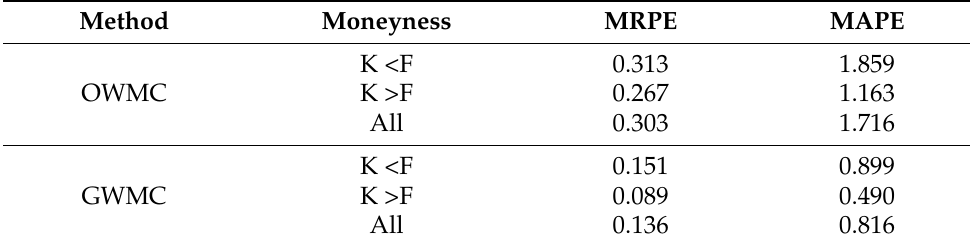
Table 6. Intertemporal run results for the OWMC method and the GWMC method using geometric Brownian motion as an initial model for OTM puts (K <F) and OTM calls (K >F).